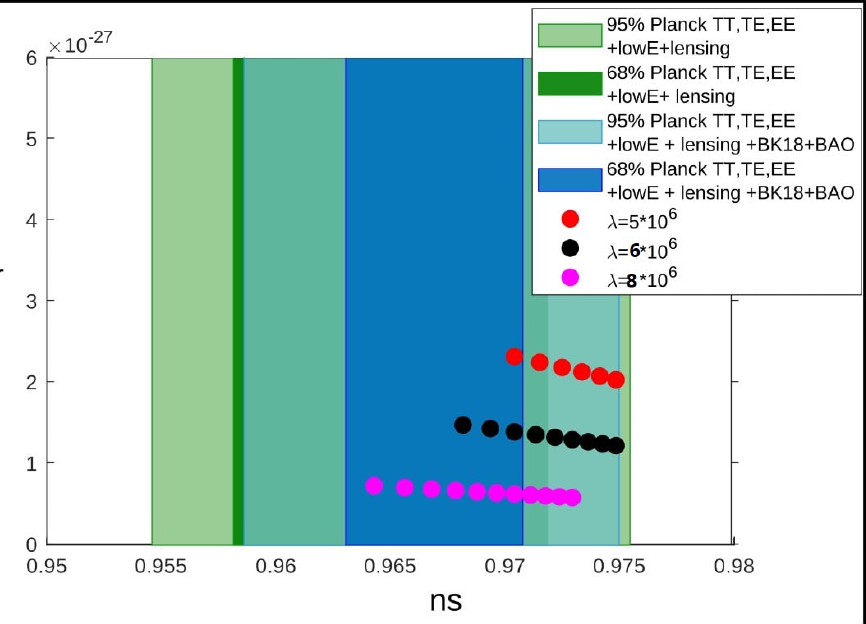
Figure 2. Predictions of warm natural inflation with periodic NMC to gravity in the strong limit. We took the values in units where Planck mass is unity ( Γ 0 = 1000, f = 100, V 0 = 1 × 10 − 6 ). For the red (black, pink) dots, we have λ = 5 × 10 6 ( 6 × 10 6 ,8 × 10 6 ) , φ ∗ ∈ [ 1 × 10 − 4 ,1.5 × 10 − 4